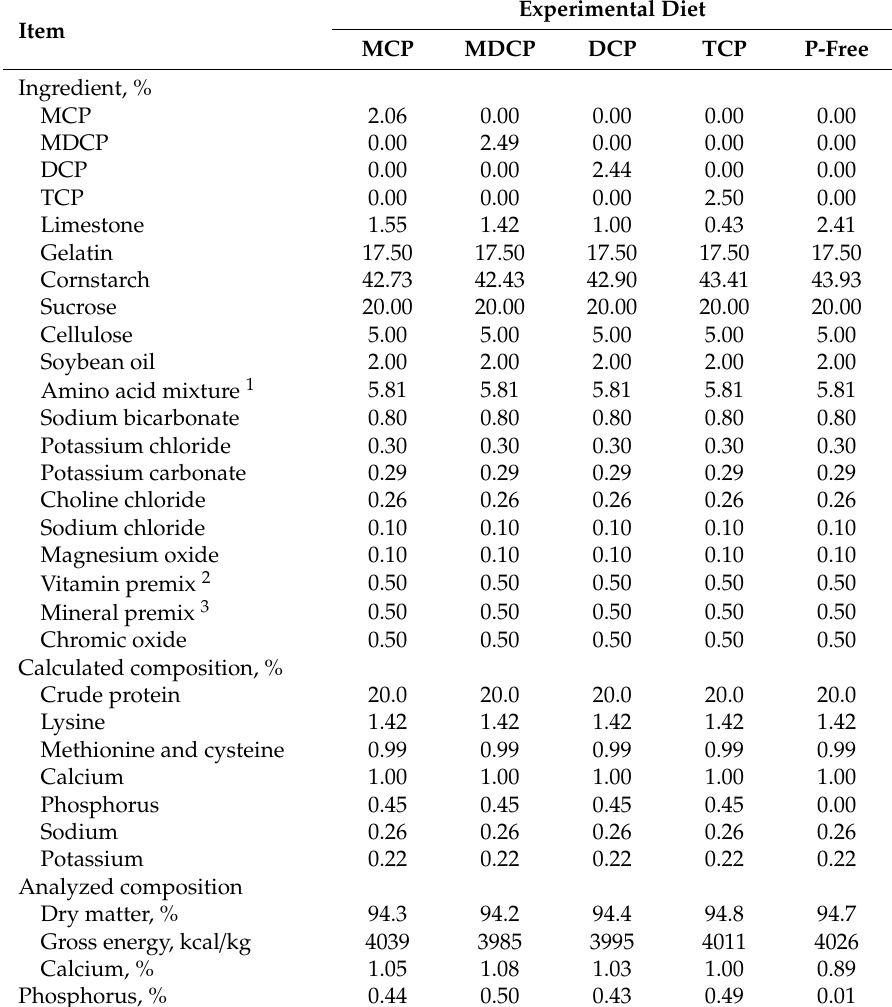
Table 2. Ingredients and chemical compositions of the experimental diets (as-fed